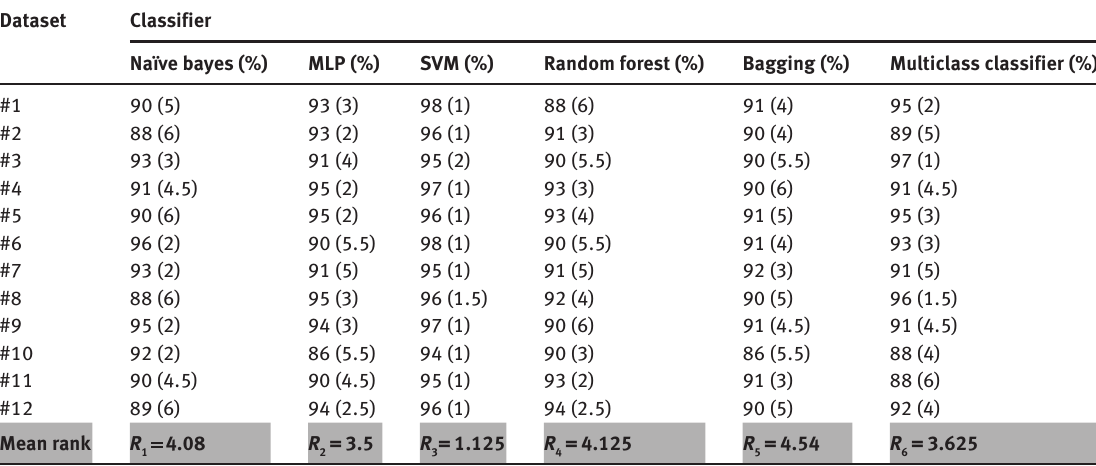
The mean ranks scored by individual classifiers are shaded in gray and styled in bold.